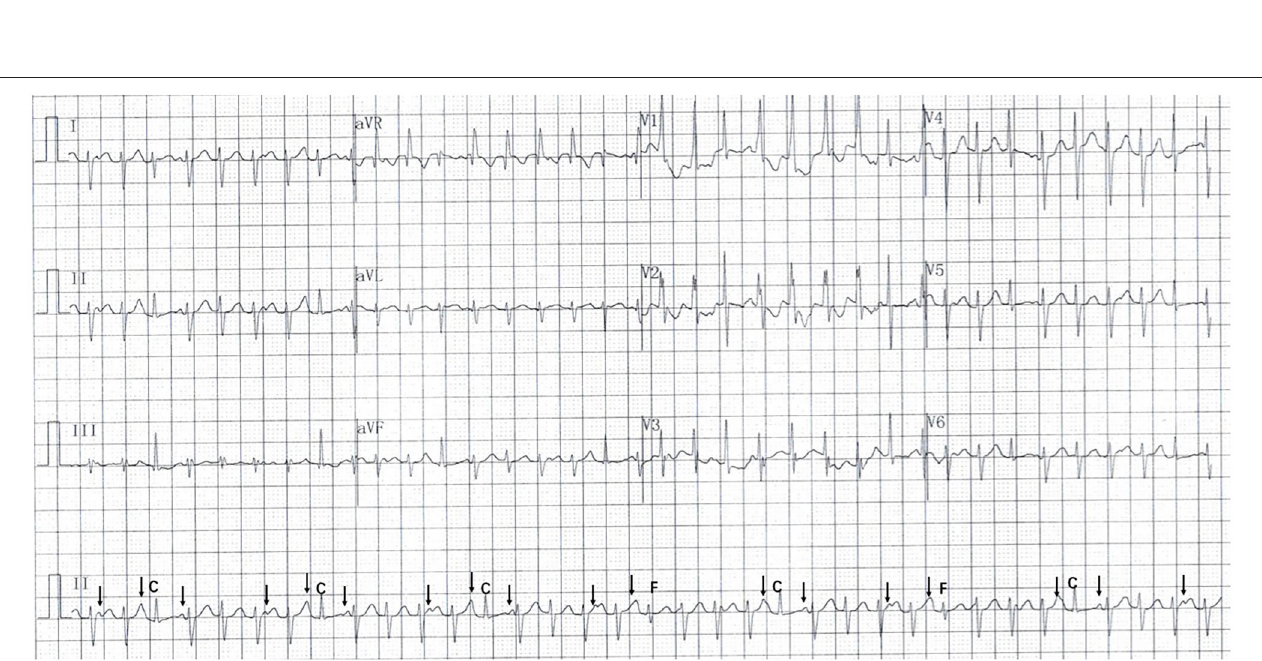
Frontiers in Pediatrics | www.frontiersin.org